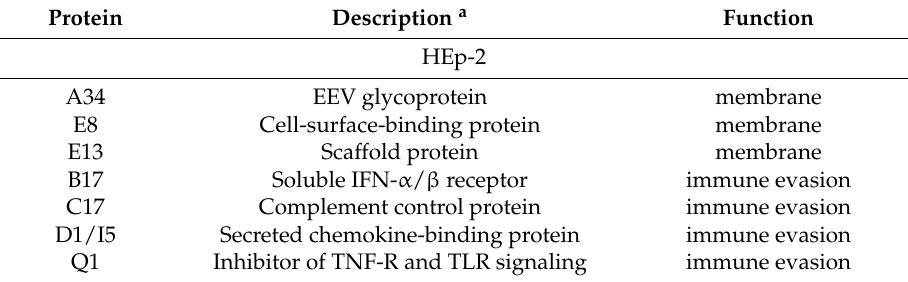
Table 2. Function of viral proteins changing in a cell type-specific manner during passaging. Protein Description a